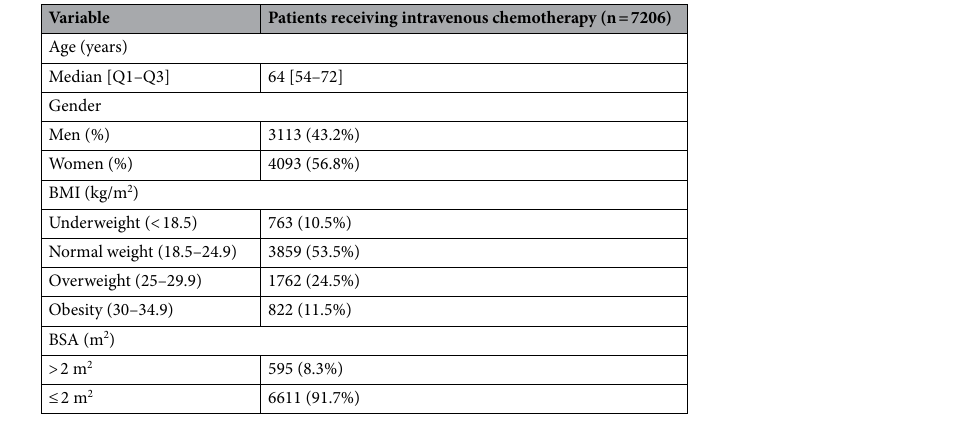
Table 1. Patients characteristics (n =